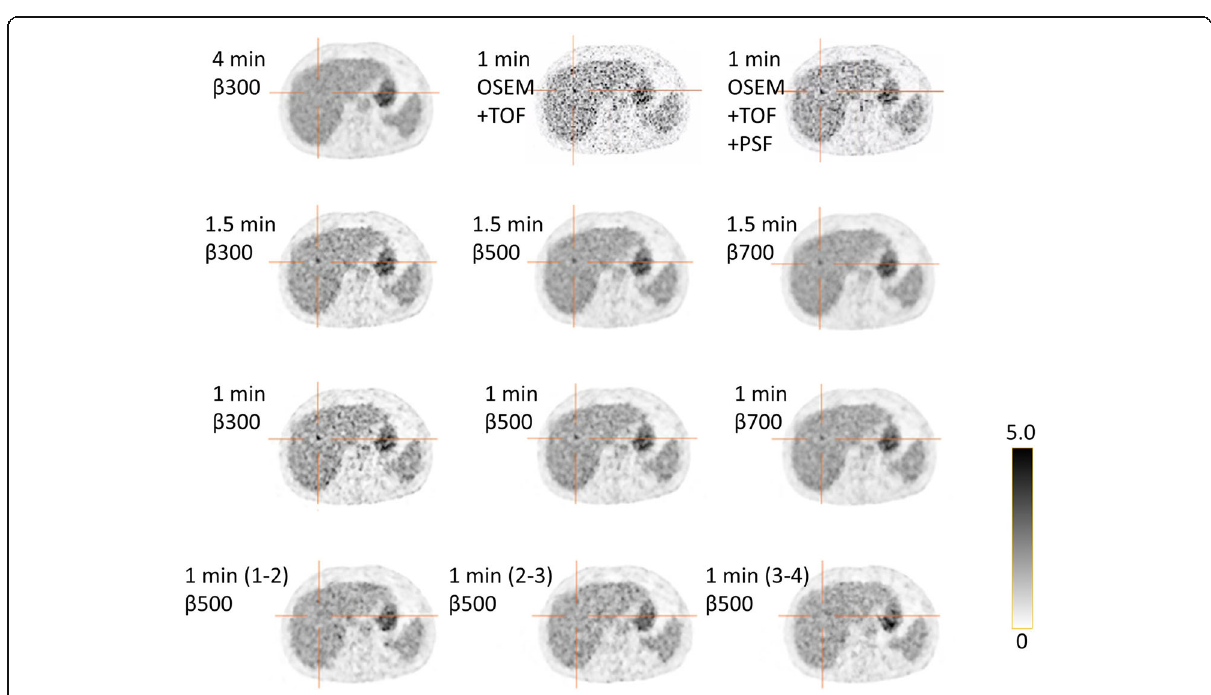
Fig. 6 Example of a lesion in the liver not visible in the 4-min reference (upper left corner), to different degrees, visible in the other combinations of time/bed position and β values evaluated. The last row shows 1-min reconstructions from the 4-min acquisition for the last 3 min, where the lesion is not visible. OSEM+TOF with and without PSF are shown in the upper